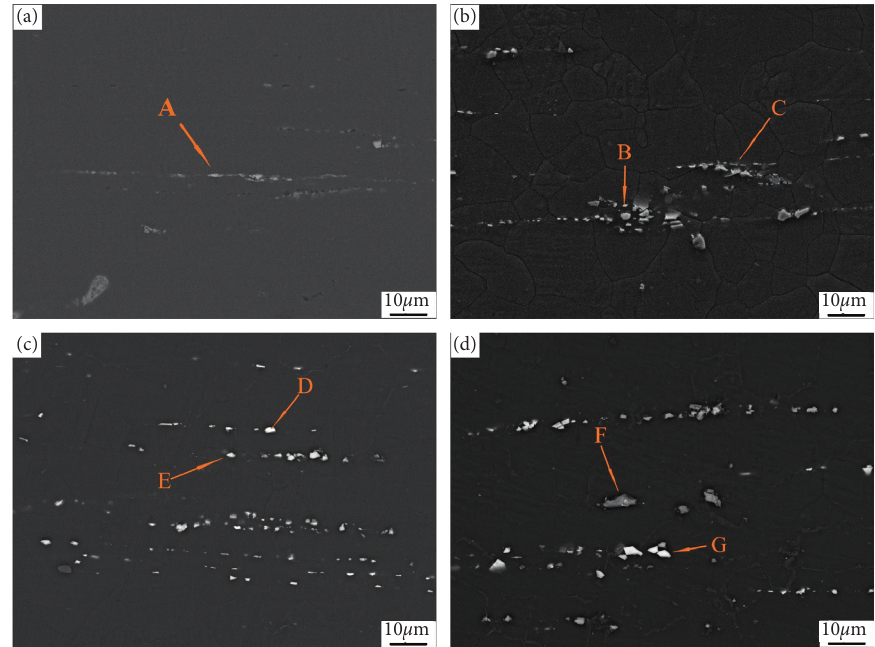
Figure 4: SEM morphologies of as-extruded AZ-0.3La alloys: (a) AZ01-0.3La; (b) AZ31-0.3La; (c) AZ61-0.3La; and (d) AZ80-0.3La.